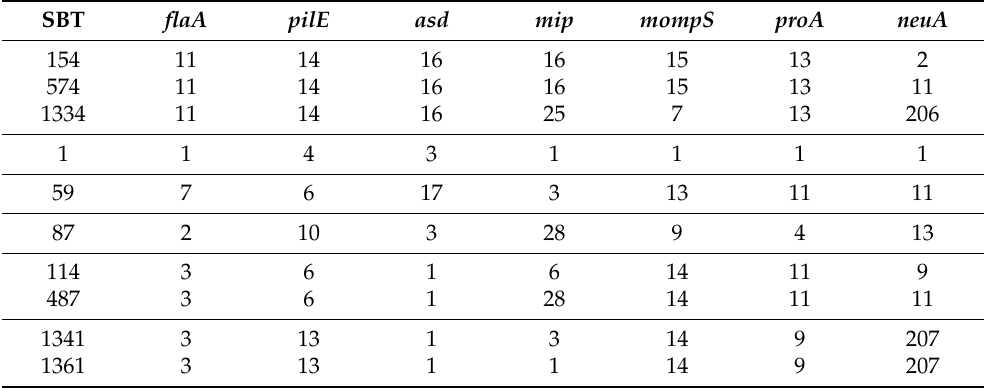
Figure 3. Maximum likelihood phylogeny of ( A ) the 28 initial Legionella culture-positive systems in Stavanger municipality and ( B ), the ST1341 isolates sampled at two different time periods. The isolates in both ( A , B ) are named according to the building code from which they were sampled. In ( A ), the different STs are represented by coloured nodes, where isolates of the same ST are seen clustering together, indicating relatedness. In ( B ), the phylogenetic relationships between the eight initial isolates of ST1341 (dark blue) and the four current isolates of the same ST (light blue) are inferred. Isolates that were sampled from the same building at two different time periods (initial and current), for example S2, cluster together, confirming that these isolates remain highly related and stable over time. Table 3. Allelic profiles of L. pneumophila isolates from the municipal shower